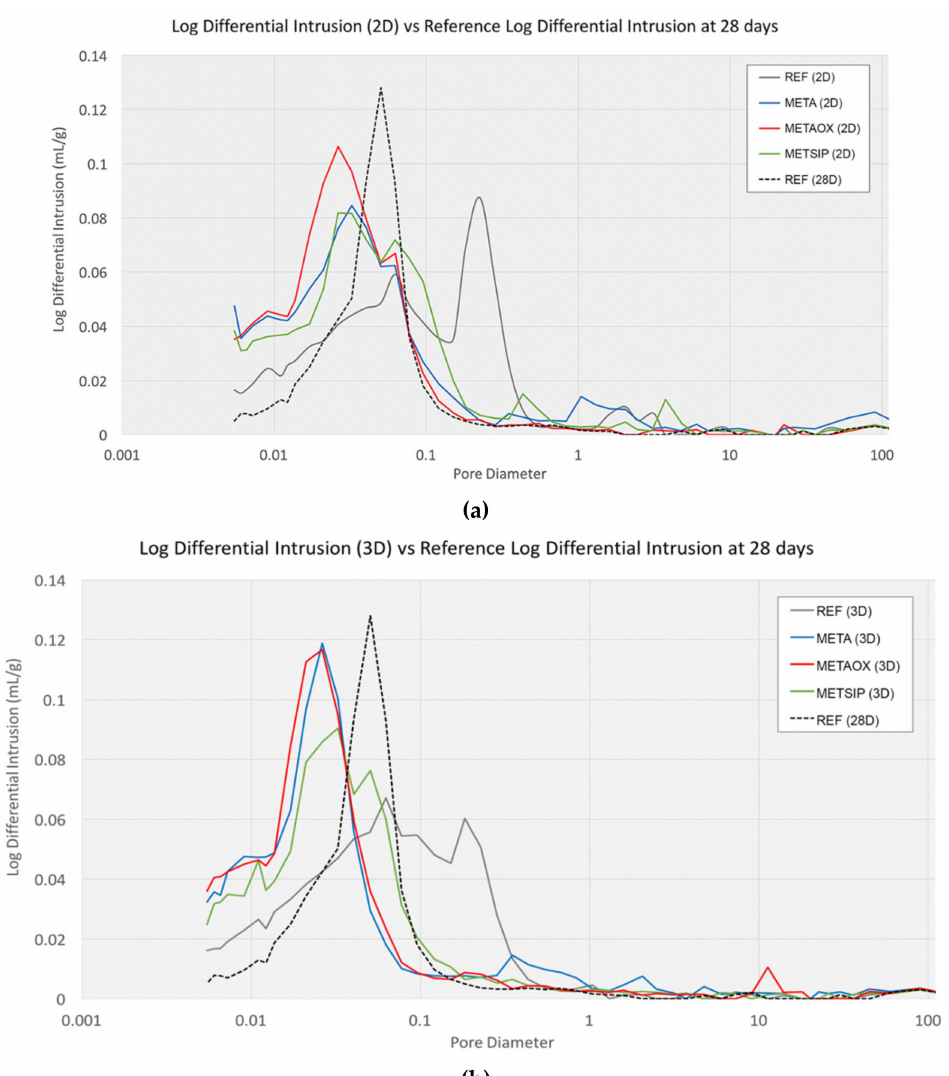
Figure 3. Logarithm di ff erential intrusion vs. pore diameter at ( a ) two days and ( b ) three days, compared with the Logarithm di ff erential intrusion vs. pore diameter of the reference mortar at 28